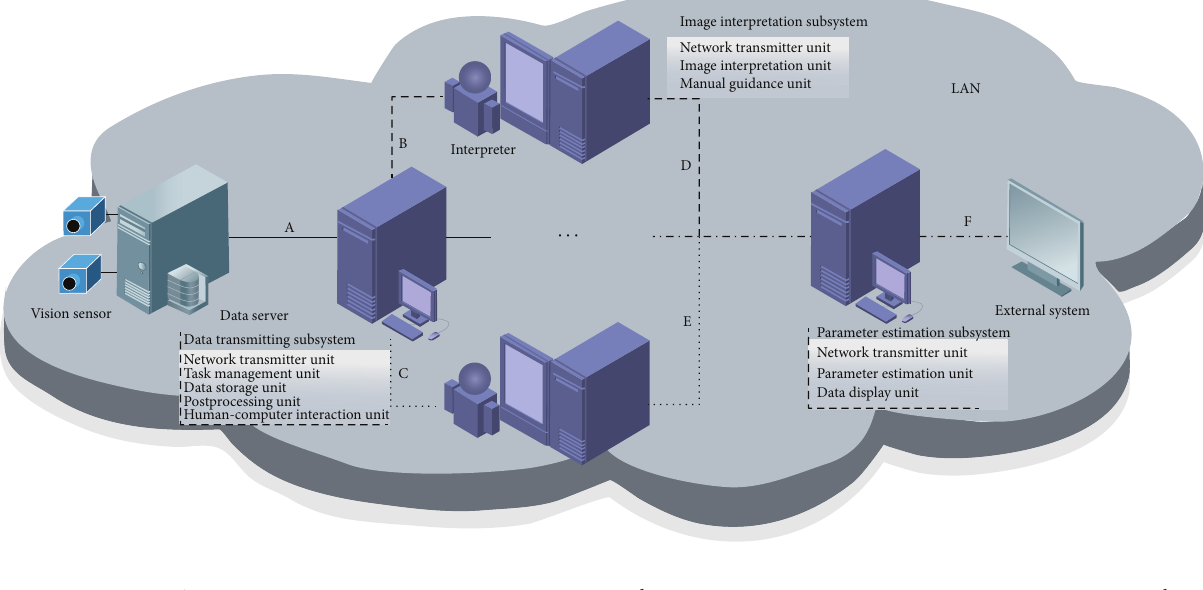
Figure 1: Architecture of distributed optical tracking and measurement processing